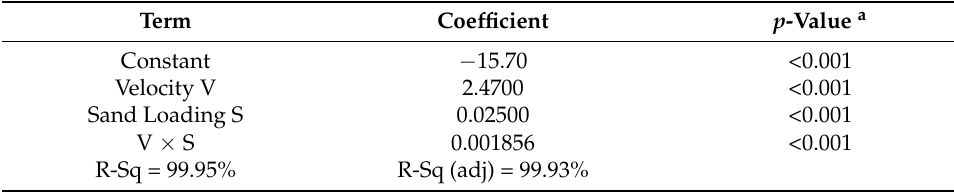
Table 6. Regression analysis for TWL .